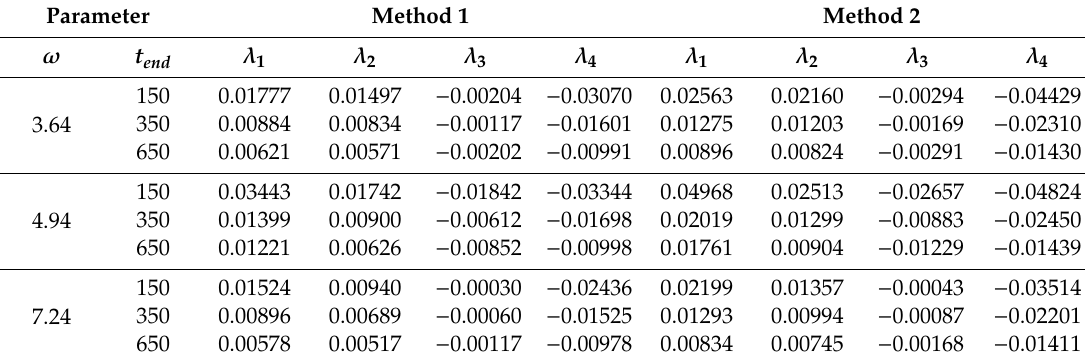
Figure 5. Time history of Lyapunov exponents for (cid:2033) = 4.94 (the case of rigid pendulum) Table 3. Spectra of Lyapunov exponents for the system with rigid